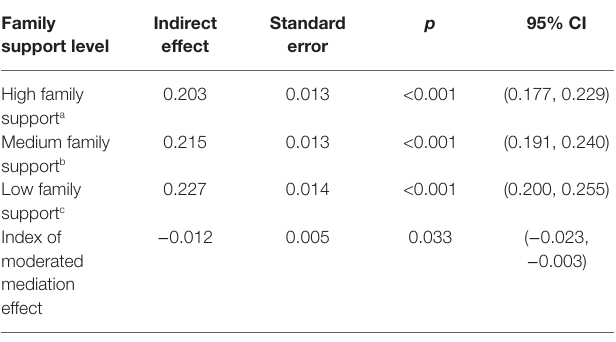
TABLE 3 | The conditional indirect effect of negative life events on antisocial behavior tendencies through self-esteem for different family support levels. Family support